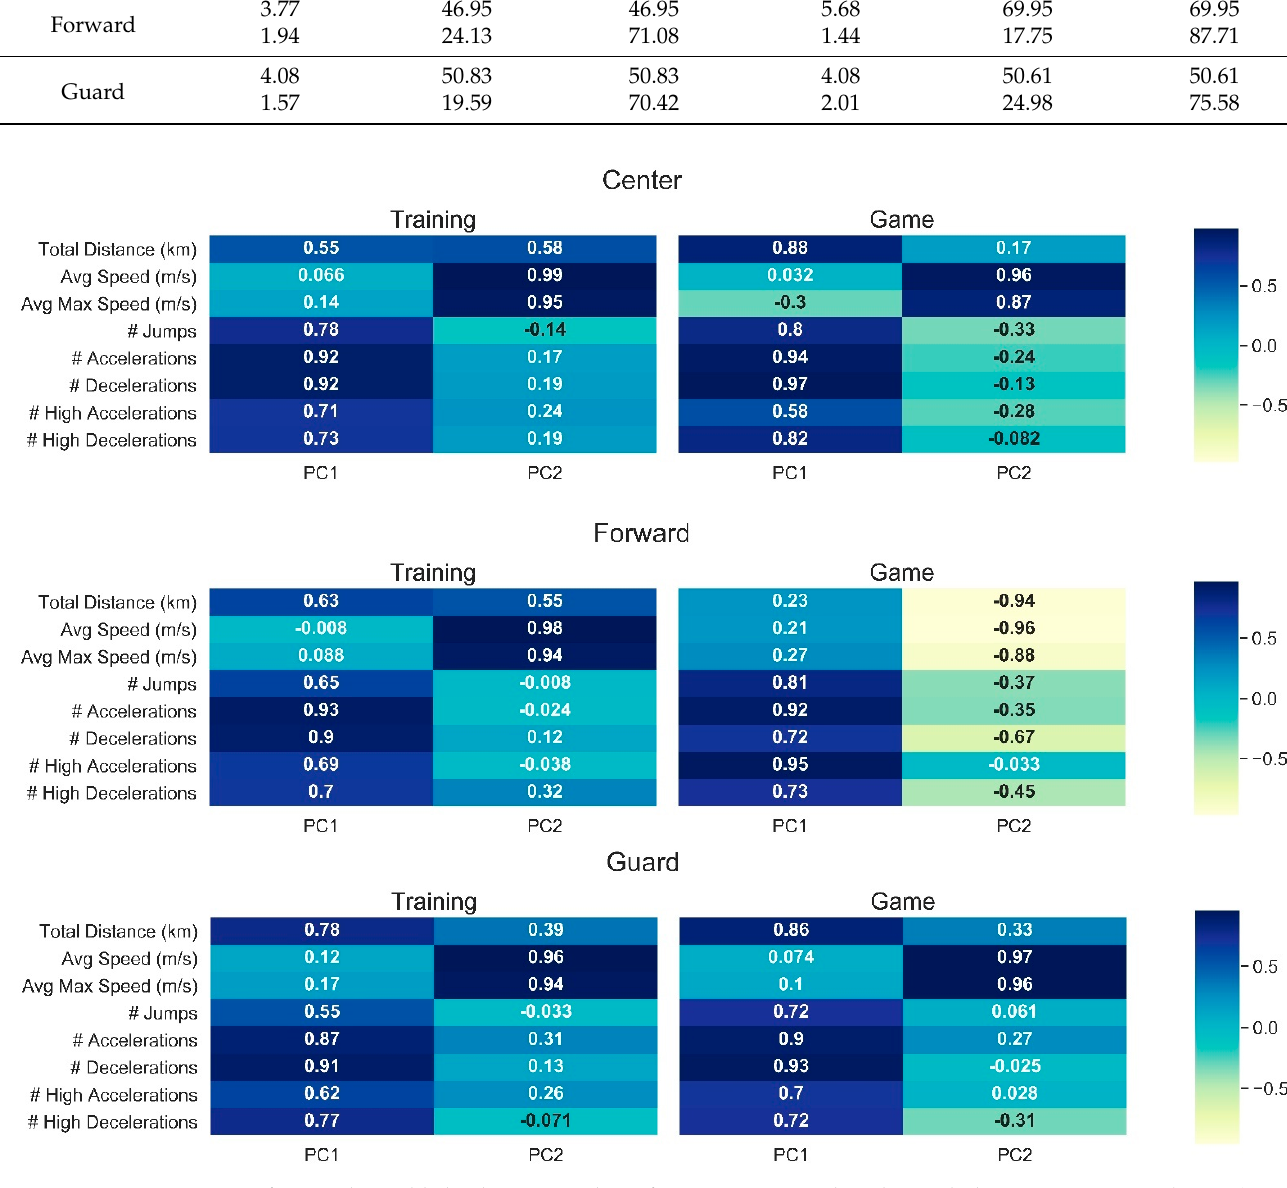
Figure 1. Heatmaps of original variable loadings on each PC for Center, Forward, and Guard playing positions. Left panels indicate the results for practice sessions, and right panels correspond to the game sessions.